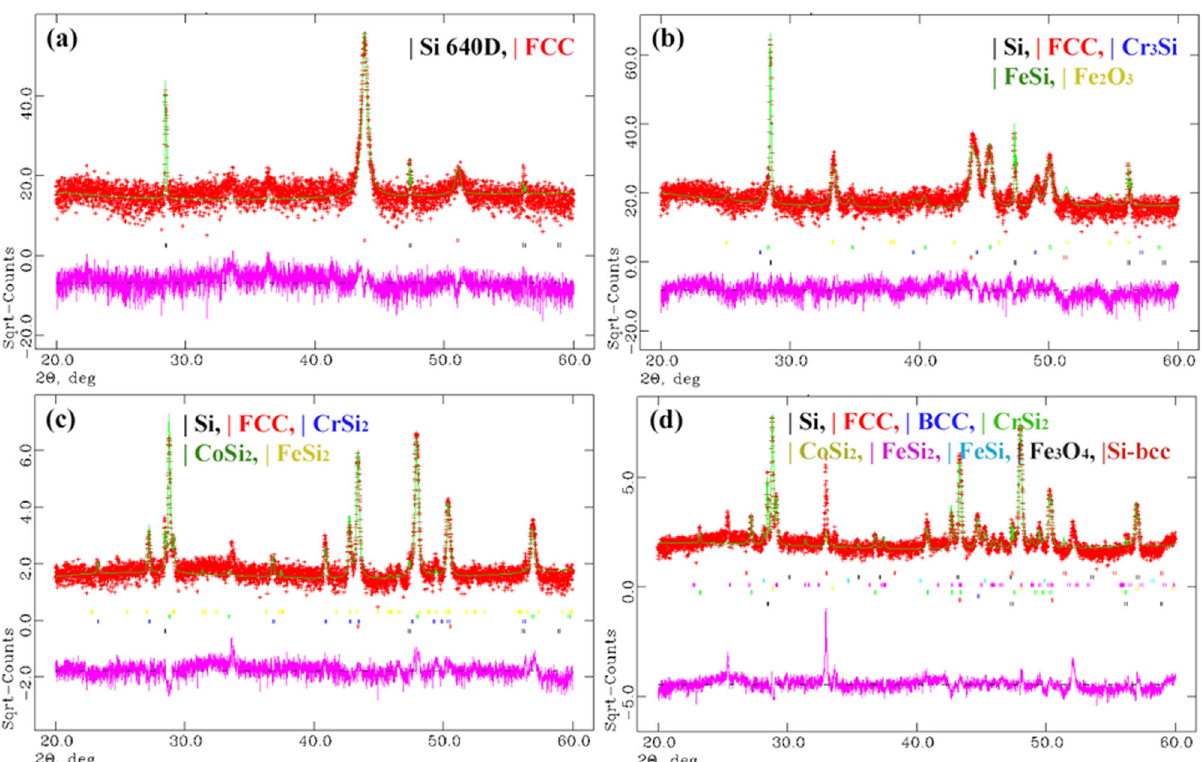
Fig. 10 XRD was used to con fi rm the phase change behavior as a function of irradiation fl uence. XRD pro fi le fi ts of a 7.1 × 10 14 cm − 2 , b 3.8 × 10 15 cm − 2 , c 2.0 × 10 16 cm − 2 , d 6.0 × 10 16 cm − 2 . Only 20 – 60° 2 θ range is shown for clarity. Color codes of tick marks of different phases are shown on each fi gure. Pink patterns at bottom of each is the residual between the experimental (red) and the fi t (light green) patterns.